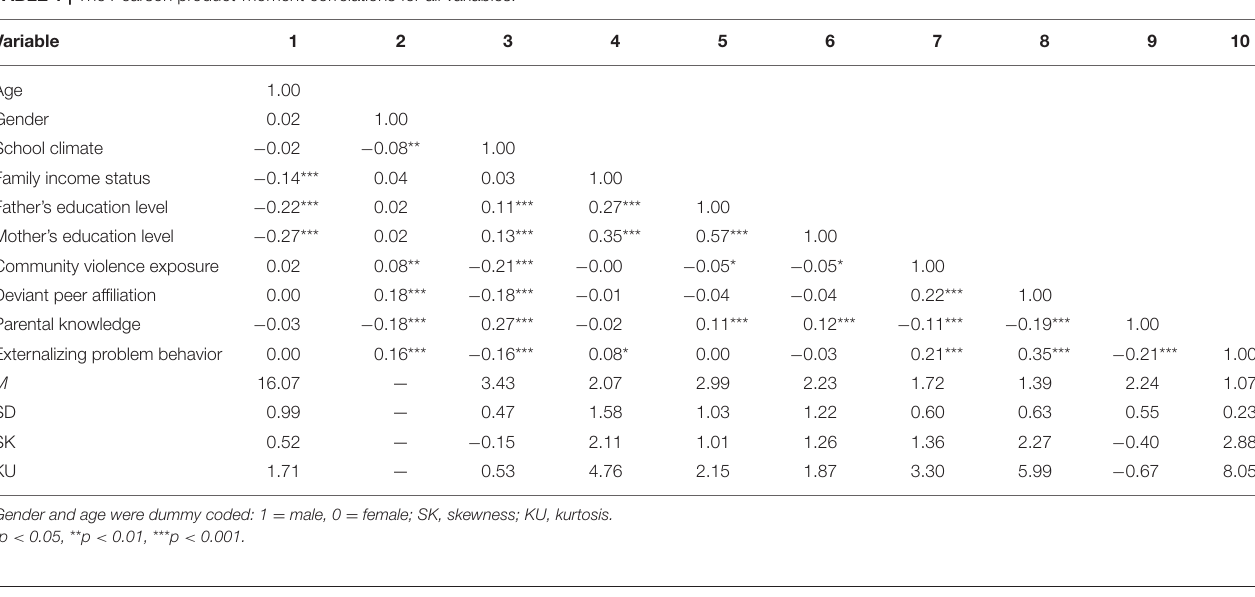
data ( χ 2 /df = 2.25, CFI = 0.97, TLI = 0.92, RMSEA